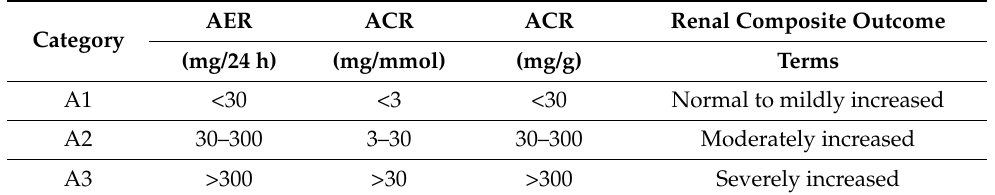
Table 2. Classification of persistent albuminuria. Adapted from KDIGO Guidelines [25] ACR: Albumin/creatinine ratio. AER: Albumin excretion rate.